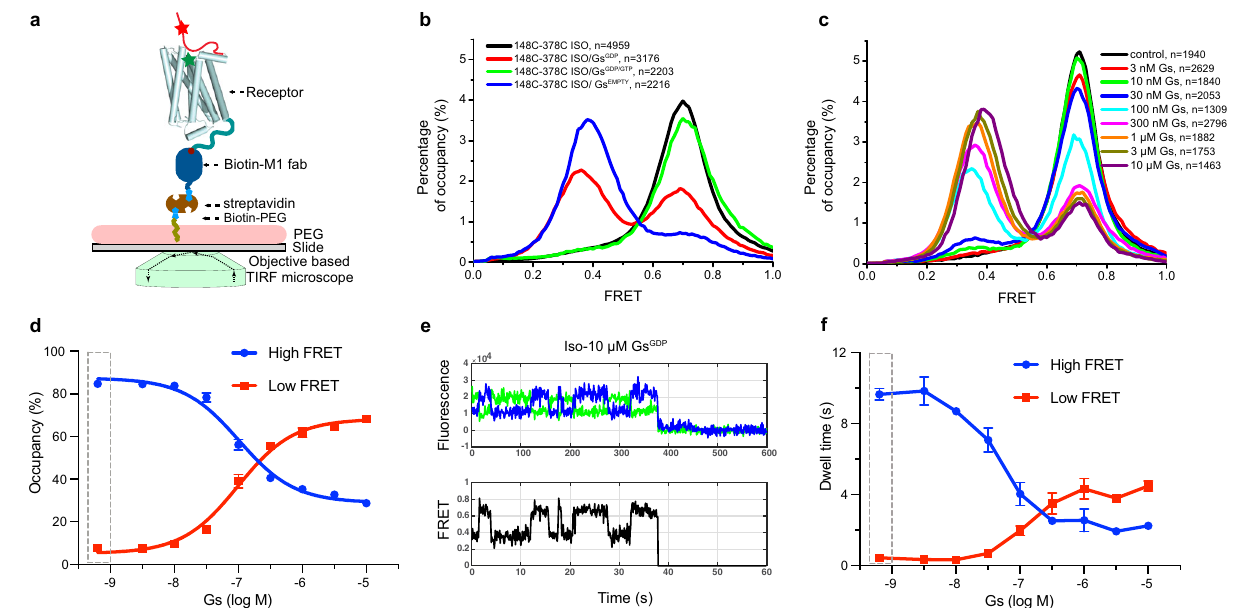
Fig. 2 | The β 2AR CT competes with Gs for binding to the receptor core. a A and error bar represent mean±s.e.m. of 3 independent experiments. The dashed rectangular box indicates the control condition without Gs. e A representative schematic model of smFRET experiments on an objective-based TIRF microscope. single-molecule trace of the dynamic ternary complex in the presence of 10 μ M Thereceptorcoredomainisshownascylindricalhelices,unstructuredCTasasolid Gs GDP and saturating isoproterenol. Donor and acceptor fl uorescence intensities red line, and representative donor and acceptor fl uorophores as red and green stars, respectively. b Representative FRET histograms of Isoproterenol occupied collected at 100ms/frame are shown as green and blue lines, respectively. FRET β β ef fi ciencyisshownasablackline.Thesudden fl uorescentdropat~38softhistrace 2 AR(148C-378C) alone, apyrase pretreatedIso- 2 AR-Gs EMPTY ternary complex,Iso- μ M GDP and 300 μ M β representsthephotobleachingofthedonor fl uorophore.ThesmFRETtracereveals 2 AR-Gs ternary complex with GDP or with a mixture of 30 GTP. c Representative FRET histograms of the 148C-378C in the presence of dif- transitions between low-FRET and high-FRET states (see also Supplementary ferent concentrations of Gs GDP with 200 μ M isoproterenol. The control sample has Fig. 5h, i). f The formation of agonist- β 2 AR-Gs ternary complex increases the low- isoproterenol alone (black), and the remaining samples include increasing con- FRETdwelltimewhiledecreasingthehigh-FRETdwelltime.Thedashedrectangular centrations of Gs GDP from 3nM to 10 μ M. d The dose-dependent effect of Gs GDP on boxindicatesthecontrolconditionwithoutGs GDP .Thehigh-FRETdwelltimeathigh theoccupancyofhigh-andlow-FRETpopulations.ThecumulativeFREThistogram Gs GDP concentration plateaus at about 2s. Bars and error bars represent the mean versusGs GDP concentrationin c was fi ttedwithadoublegaussianmodel,andthedot ±s.e.m. of 3 independent